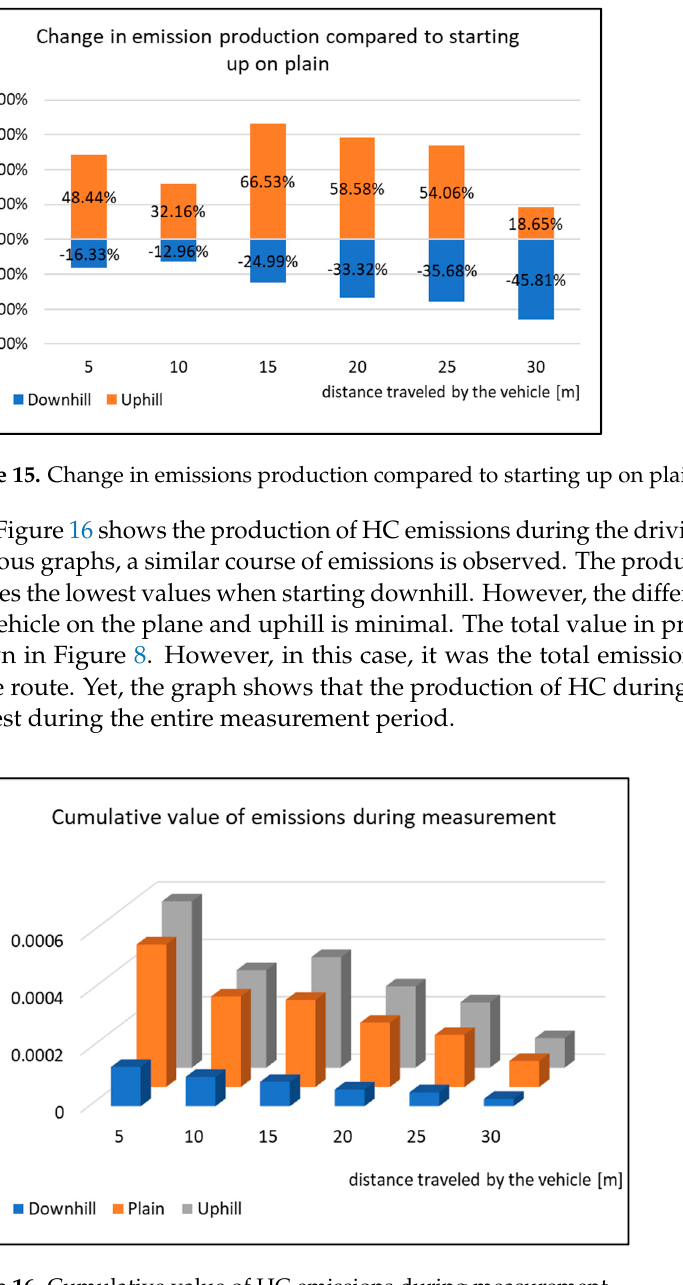
Figure 14. Cumulative value of emissions CO 2 during measurement.